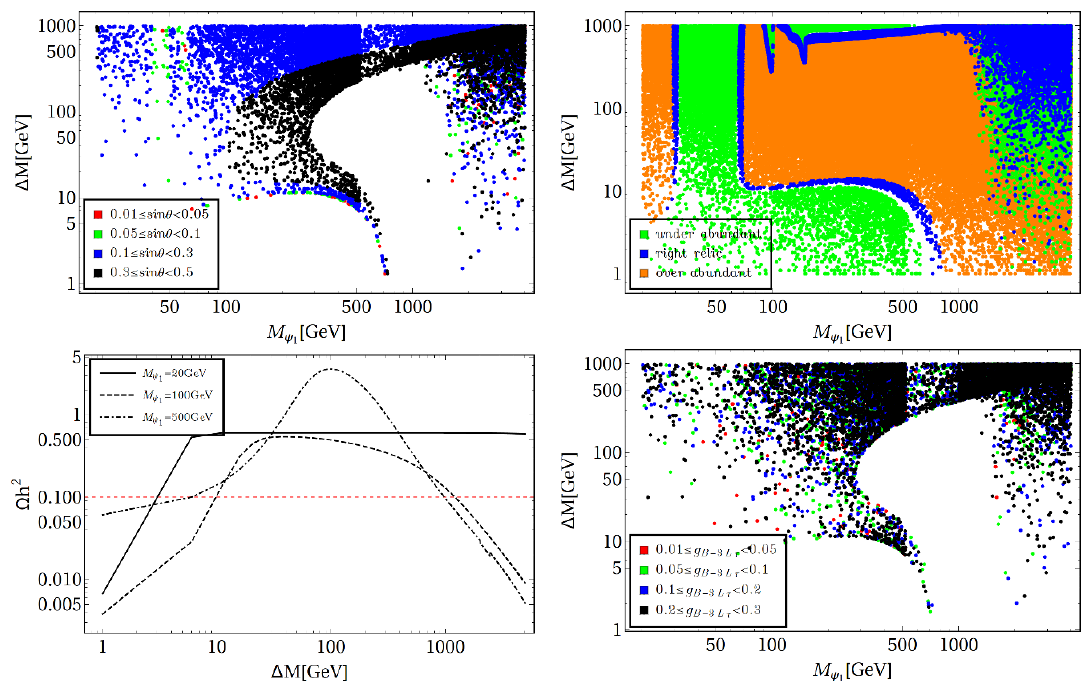
Figure 4 . Top Left: relic density allowed parameter space for DM 1 in M di(cid:11)erent ranges of sin (cid:18) depicted in the inset of (cid:12)gure where 0 : 05 (cid:20) g B (cid:0) 3 L under abundance (green region), over abundance (orange region) and right relic density (blue) regions are shown in same M -(cid:1) M plane for a (cid:12)xed sin (cid:18) = 0 : 2 . Bottom left: variation of relic 1 abundance with (cid:1) M for some choices of DM mass: 20 GeV (solid black curve), 100 GeV (dashed black curve) and 500 GeV (dot dashed black curve). For this plot g B (cid:0) 3 L sin (cid:18) = 0 : 2. The horizontal dashed line (red coloured) corresponds to the central value of Planck limit on DM relic [4] Bottom right: relic density allowed parameter space in M di(cid:11)erent ranges of g B (cid:0) 3 L depicted in the inset of (cid:12)gure and sin (cid:18) : f 0 : 01 (cid:0) 0 : 5 g . (cid:28)